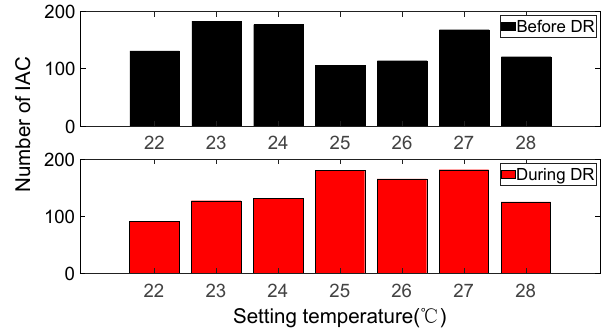
Figure 8. Distribution of the setting temperature.